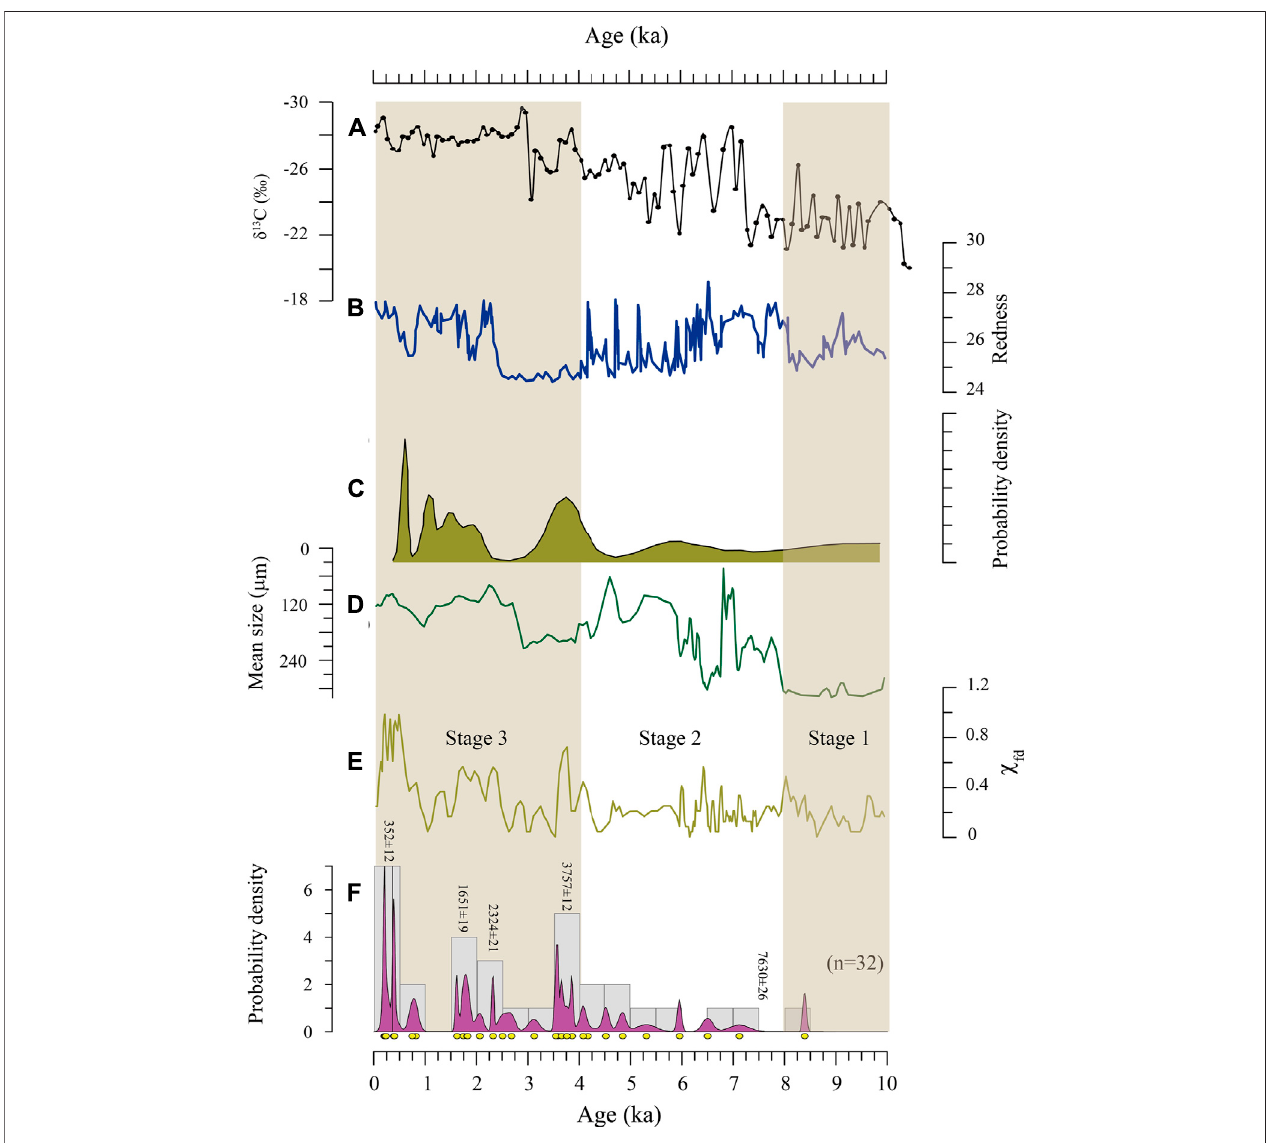
FIGURE 4 | (A) Organic δ 13 C records indicating the variation in water depth (Liu et al., 2013b) and (B) Redness-inferred precipitation at Qianghai Lake (Ji et al., 2005). (C) OSLagesprobabilitydensityforsandyloessfromtheAnyemaqenMountains(Stauch,2015). (D) Meangrainsizeand (E) Mass-speci fi cfrequency-dependent susceptibility ( χ fd ) from the MQQ pro fi le. (F) Probability density function of radio carbon ages for paleosols since the early Holocenein the eastern Tibetan Plateau. Radio carbon ages of paleosols are from (Xu, 1994; Zou and Wang, 1995; Fang et al., 1998; He et al., 2006; Lehmkuhl et al., 2014; Hu et al., 2016), and this study.